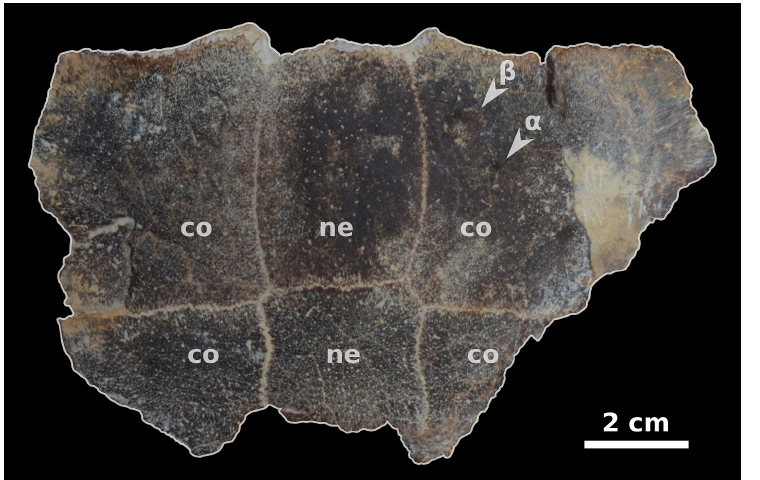
Figure 2. MUSM 4716, fragmentary turtle carapace from the Upper Miocene (Tortonian) strata of the Pisco Formation (Peru), in dorsal (external) view. The arrowheads indicate the location of two traces ( α and β ) detailed in Figure 3 (note that light conditions were not set with the purpose of highlighting those scars when taking this photograph). Abbreviations: co, costal plate; ne, neural plate.